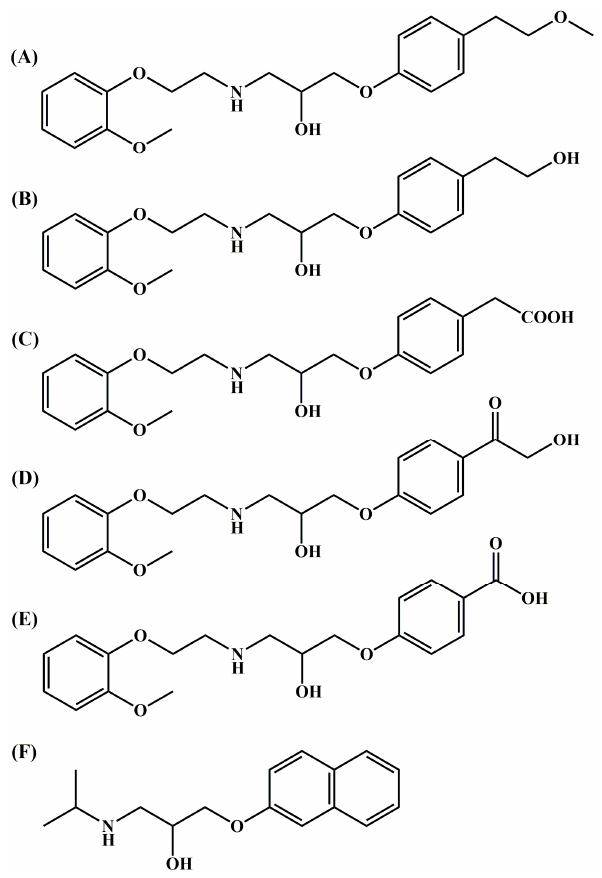
Figure 1. Chemical structures of ( A ) TJ0711, ( B ) M1, ( C ) M3, ( D ) M4, ( E ) M16, and ( F ) Propranolol.